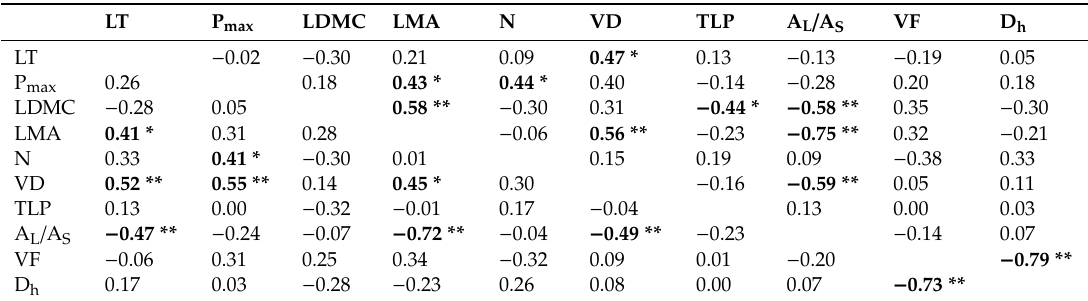
− Table 2. Pearson correlation coefficients (lower diagonal) and phylogenetically independent contrasts (upper diagonal) among 10 leaf traits.